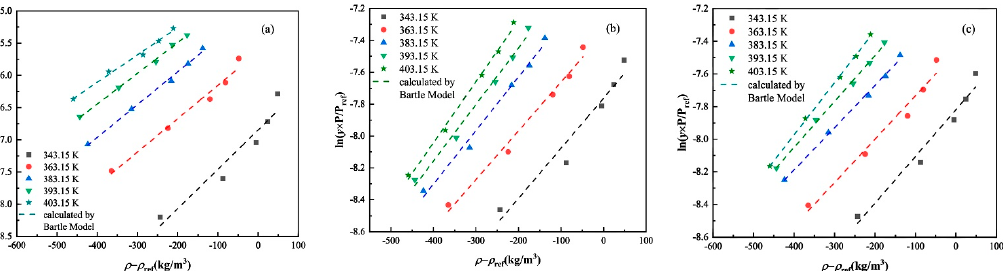
Figure 5. Solubilities in sc − CO 2 calculated by the Bartle model for ( a ) DR 73, ( b ) DR 19, ( c ) DO S − RL.